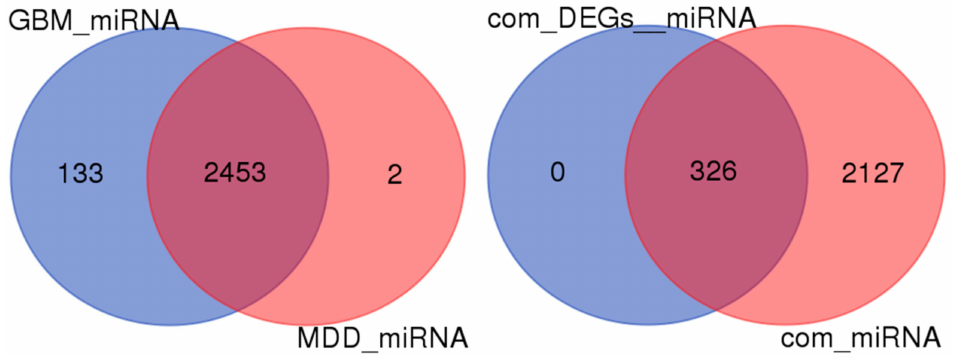
Figure 5. The predicted miRNA Venn Diagram. GBM_miRNA: the miRNAs predicted by GBM-related DEGs; MDD_miRNA: the miRNAs predicted by MDD-related DEGs;